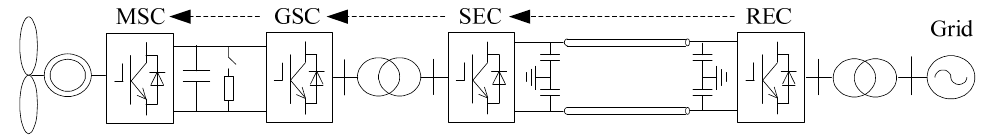
Figure 9. Communication link between VSC-HVDC and PMSG WT.